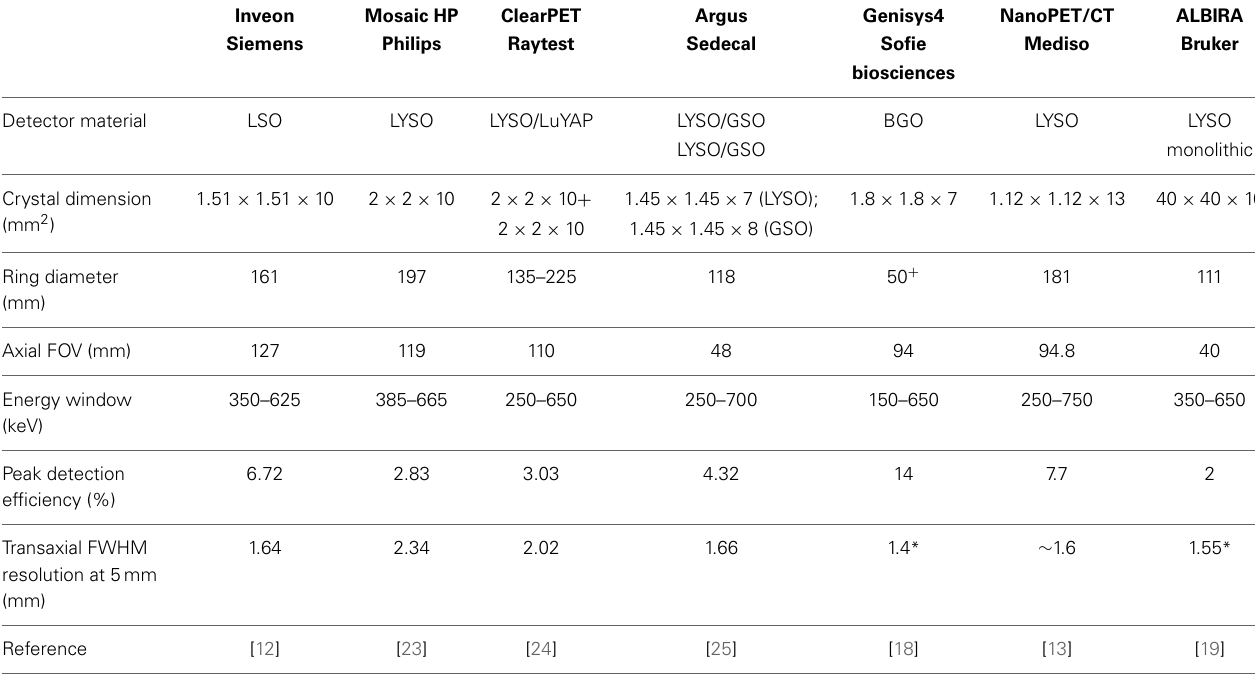
Table 1 | Characteristics of preclinical PET